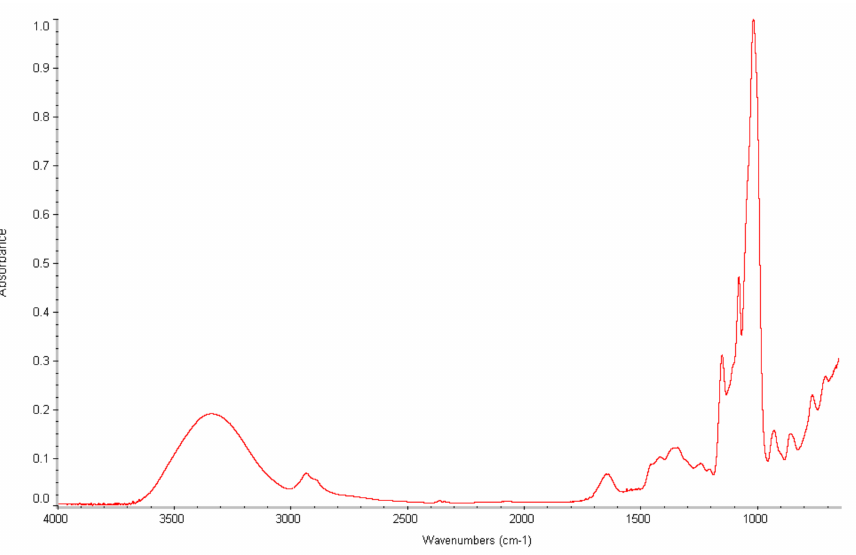
Figure 2. FTIR-ATR spectrum of Ginkgo biloba starch.